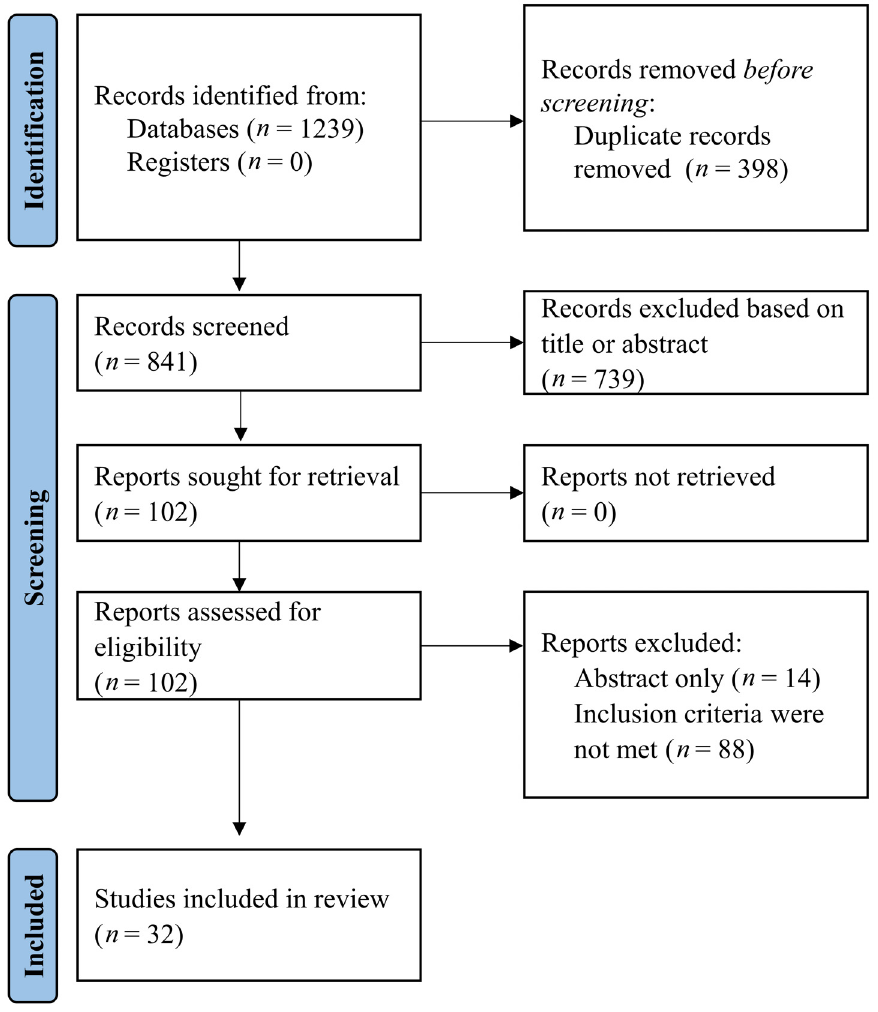
Figure 1. PRISMA Flow diagram for study selection.